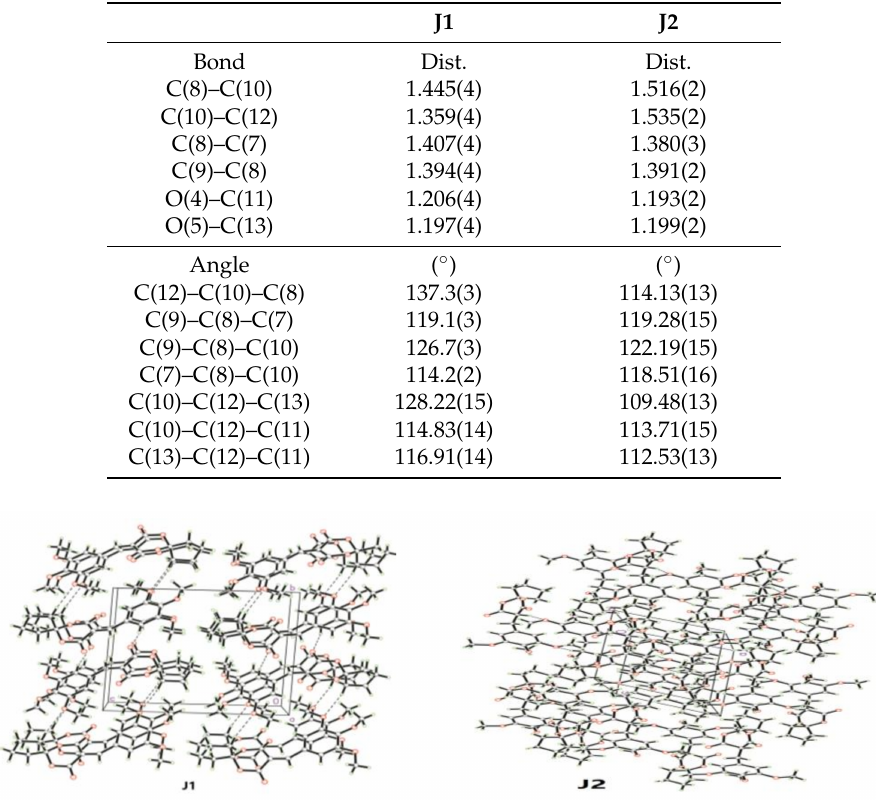
Table 2. Selected bond lengths (Å) and bond angles ( ◦ ) of J1 and J2 .